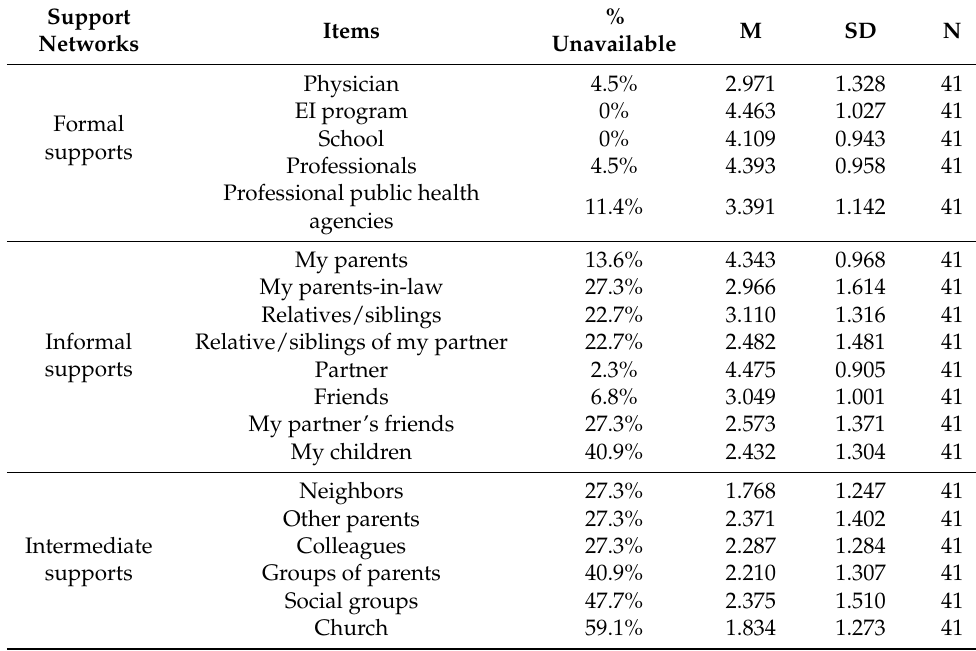
Table 5. Informal, intermediate, and formal support